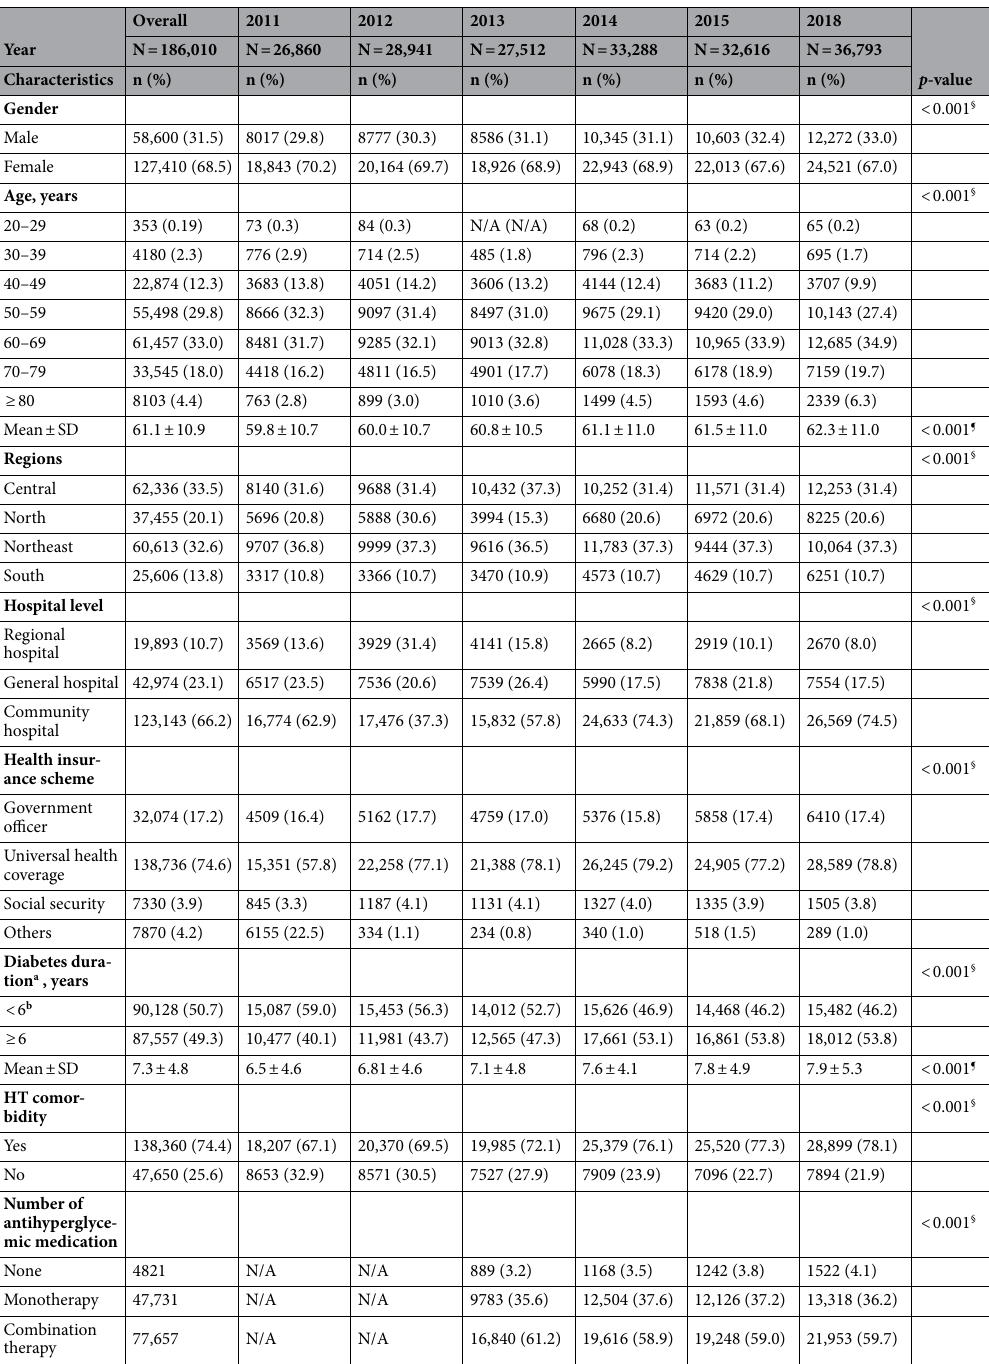
Table 1. Demographic characteristics of the enrolled patients with type 2 diabetes from 2011 to 2016 and 2018. SD: standard deviation; HT: hypertension. § Chi-square test, ¶ ANOVA. a There were 8325 missing values for diabetes duration. b Cut-off points at the